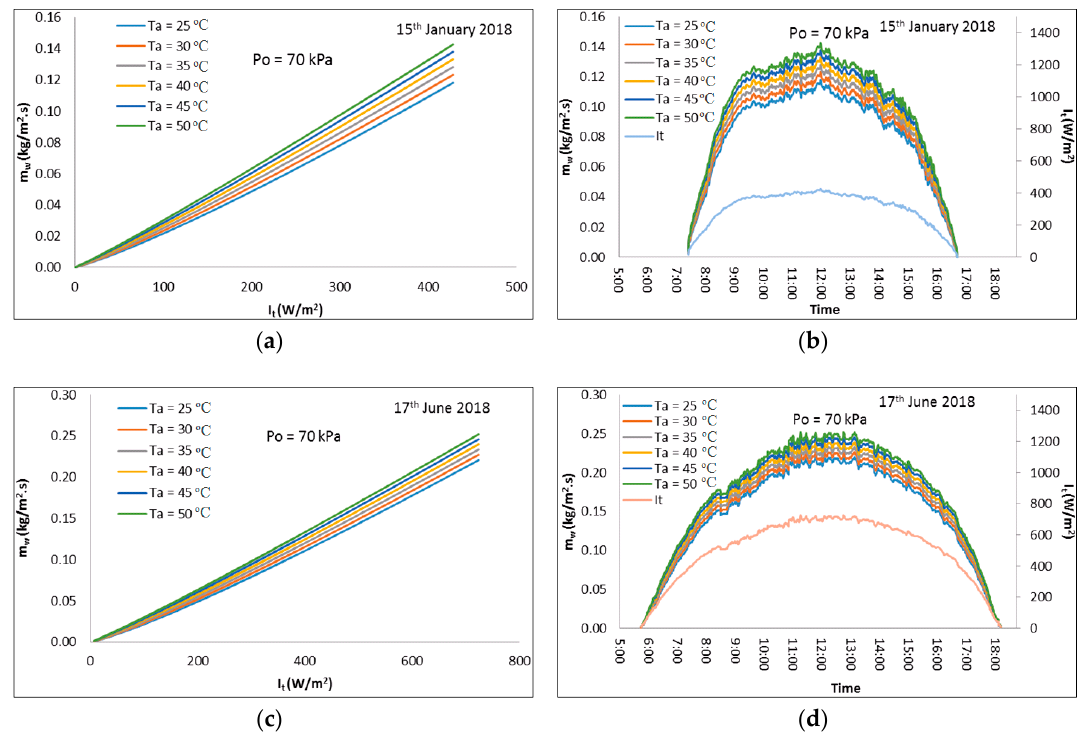
Figure 8. Effect of ambient temperature on the production of a geothermal solar still. ( a , b ) represent analysis for a winter’s day on 15 January 2018. ( c , d ) represent analysis for a summer’s day on 17 June 2018.